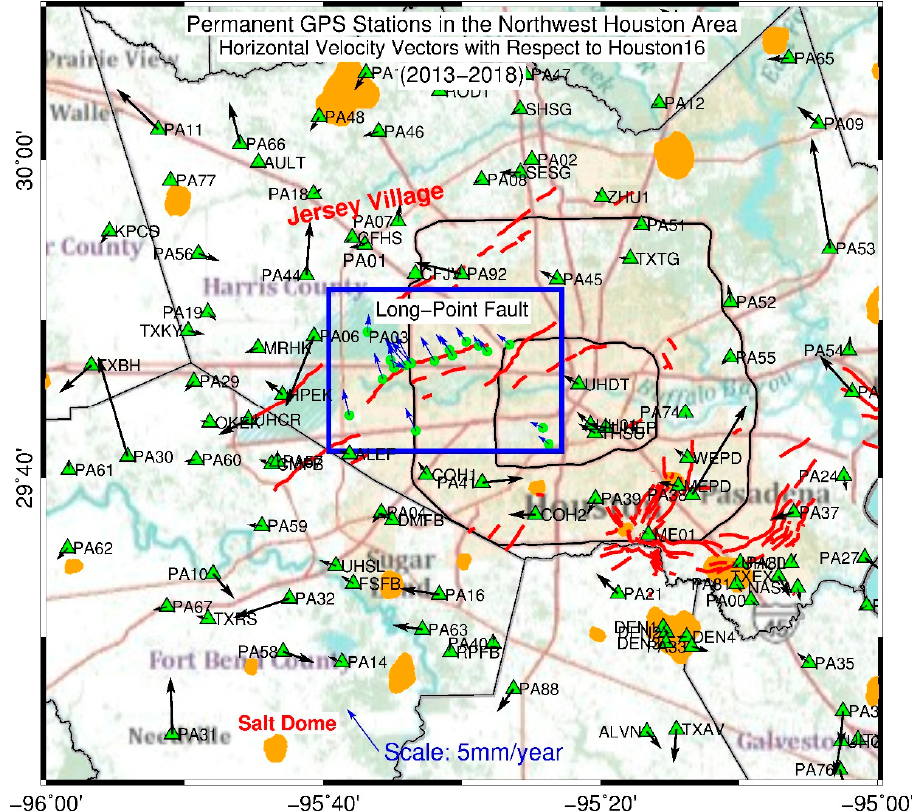
Figure 1. Permanent GPS stations in the western part of the Houston metropolitan area and their horizontal site velocities derived from continuous GPS observations during the period from 2013 to 2018. The uncertainties (2 σ , 95% confidence level) of the horizontal velocities are below ±0.5 mm/year. The blue rectangle indicates the Long Point Fault area. The red lines represent active faults in the Houston Metropolitan area mapped by USGS [12]. The orange filled polygons represent salt domes mapped by USGS